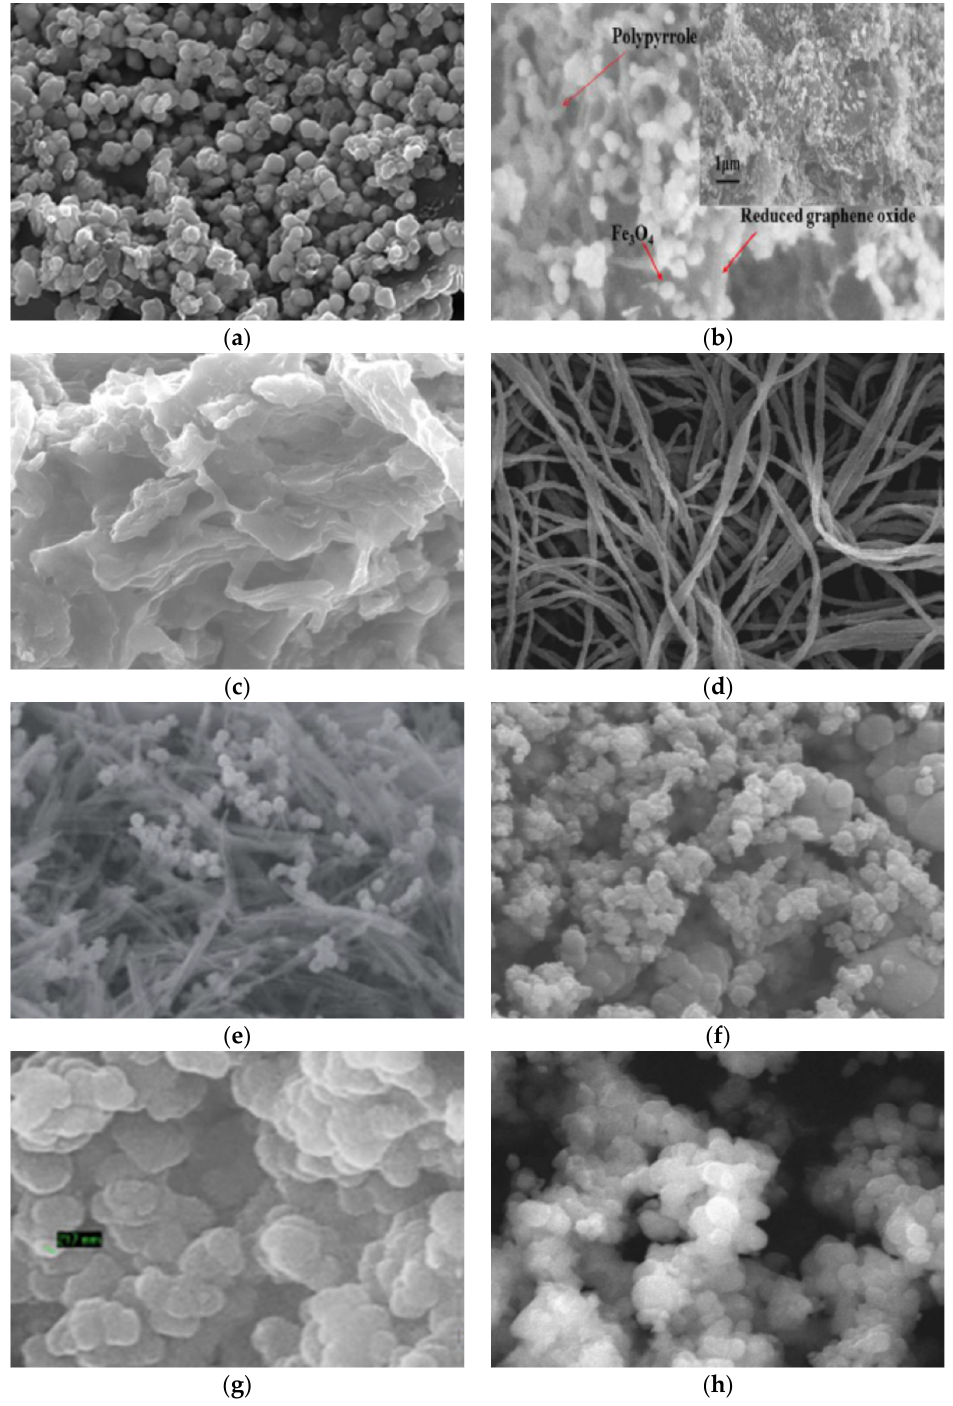
Figure 8. Some representative SEM images of Ppy and Ppy-based composite materials. ( a ) Magnetic Fe 3 O 4 @Arg-Ppy